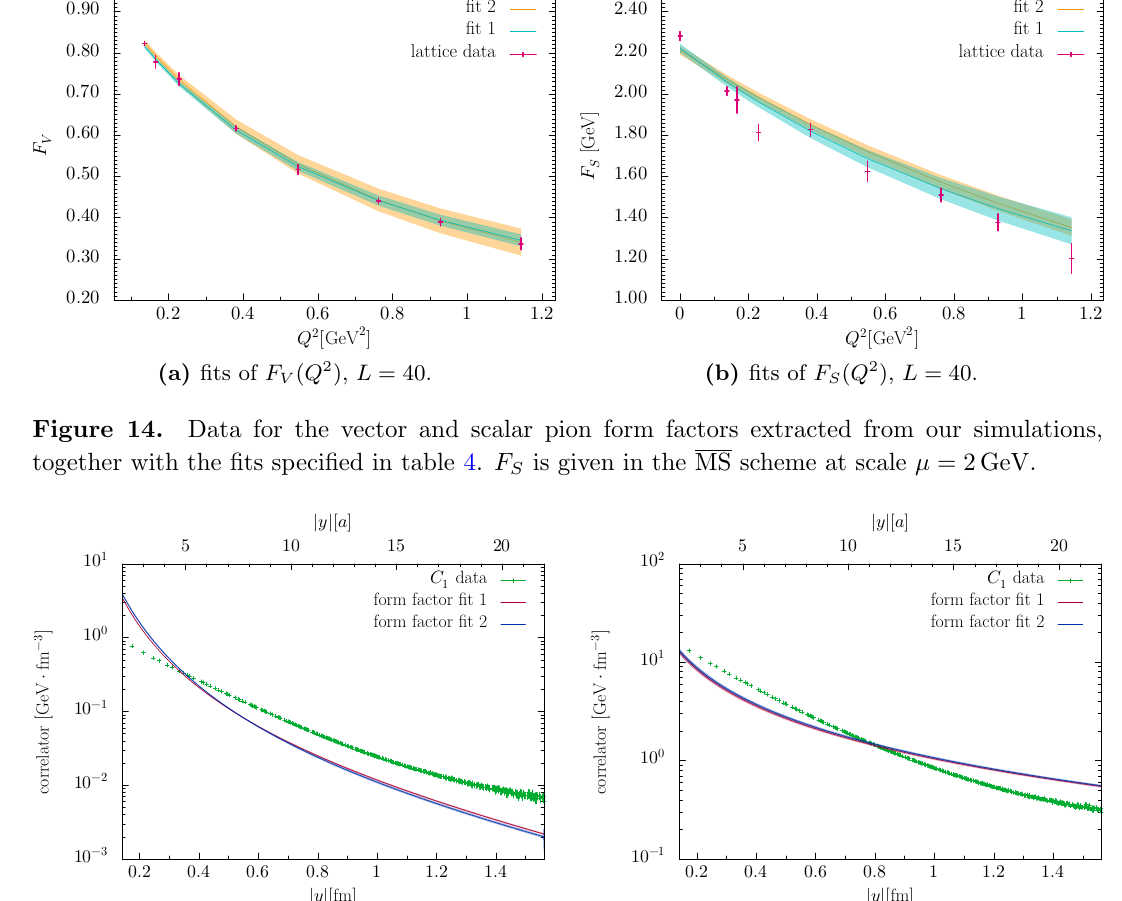
V 0 V 0 and SS . h i h i